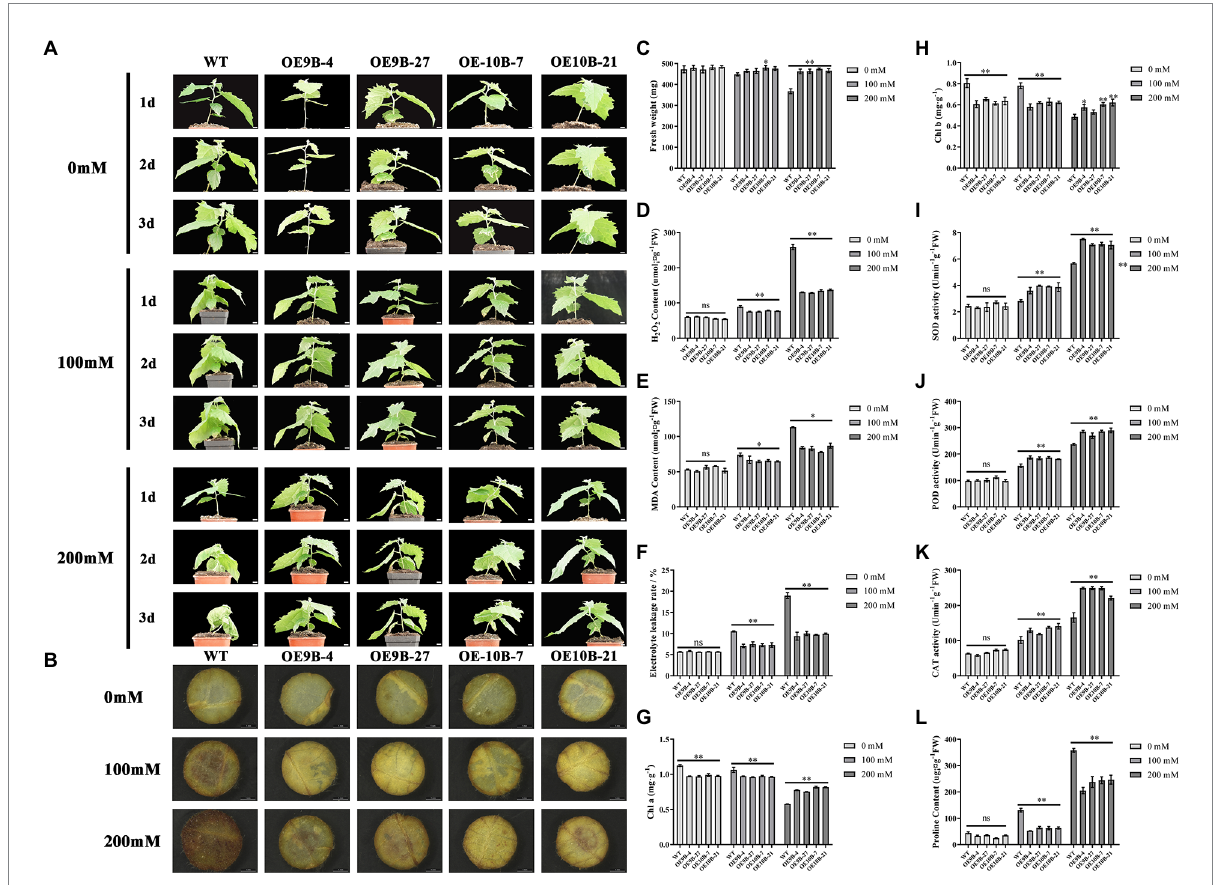
FIGURE 7 Overexpressing PagALKBH9B and PagALKBH10B enhanced salt tolerance in transgenic poplars. (A) The phenotype of transgenic lines and WT under 0, 100, and 200 mM NaCl treatment. Bar = 1 cm. (B) Histochemical detection of H 2 O 2 accumulation of WT and transgenic lines under a certain concentration salt treatment by DAB staining. (C) The fresh weight of leaves of WT and transgenic lines under a certain concentration salt treatment. (D) Histochemical detection of H 2 O 2 accumulation of WT and transgenic lines under a certain concentration salt treatment. (E) Histochemical detection of MDA contents of WT and transgenic lines under a certain concentration salt treatment. (F) The electrolyte leakage rates of WT and transgenic lines under a certain concentration salt treatment. (G) The Chl content of WT and transgenic lines under a certain concentration salt treatment. (H) The Chl b content of WT and transgenic lines under a certain concentration salt treatment. (I–K) Antioxidant enzyme activity in transgenic lines compared with WT after salt treatment, respectively. (L) Histochemical detection of proline contents of WT and transgenic lines under a certain concentration salt treatment. The experiments were performed three times and the similar results were obtained, at least six 84K poplars were collected as a replicate. The bars represent means ± SE ( n = 6) and the asterisks indicate significant differences between WT and transgenic plants ( * p < 0.05, ** p <